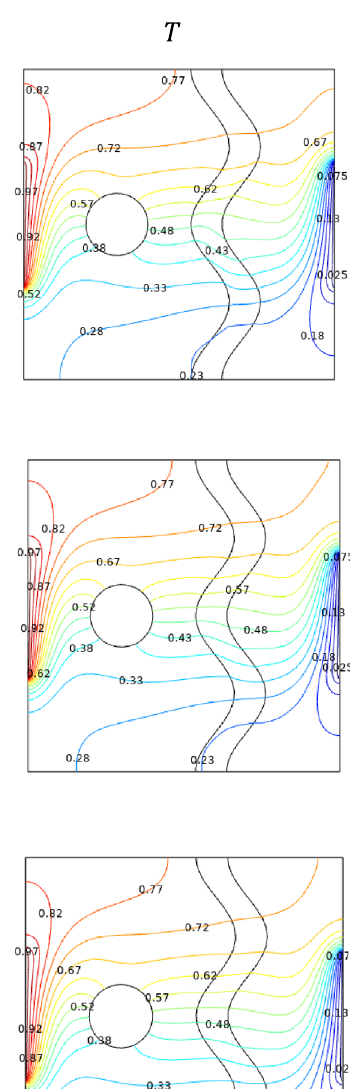
Figure 11. Variations of the streamlines (left), isotherms (right) with various porosity values ( ε ) at, Ra 0 , N 0.01 , and ω 0.02 , Da 2 , φ Ha = = = =